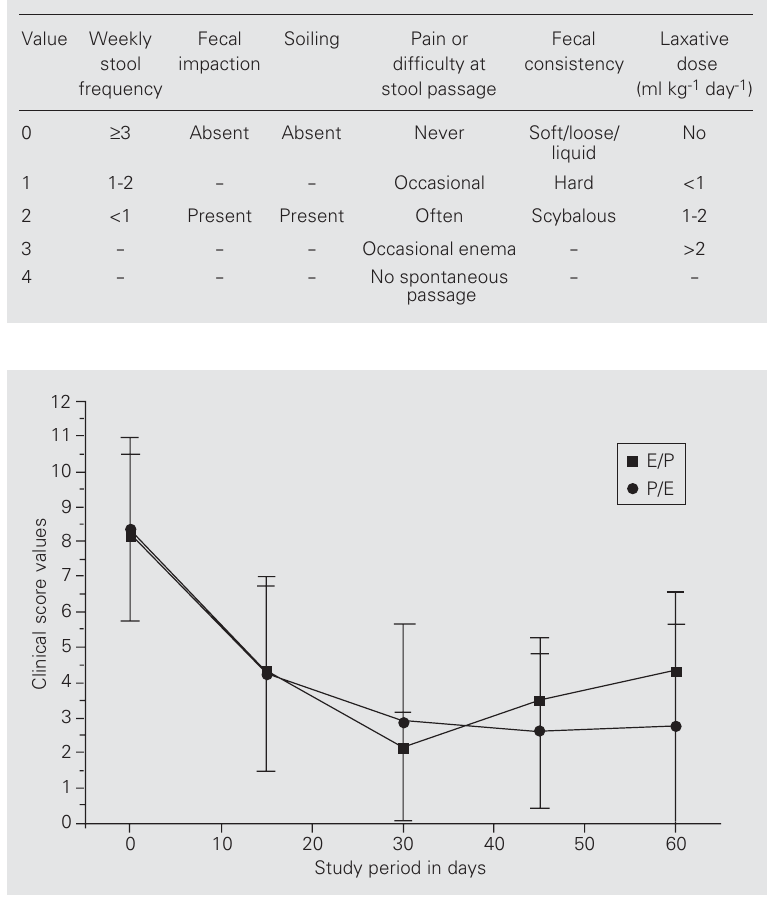
Figure 1. Clinical score outcome. Longitudinal scores (mean ± SD) for group I (erythromy- cin-to-placebo sequence, E/P, squares), and group II (placebo-to-erythromycin sequence, P/E, circles) during the crossover study are illustrated.